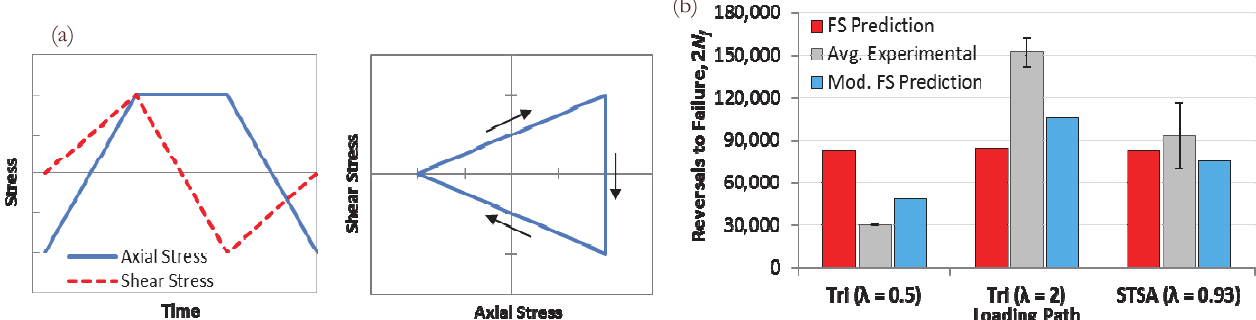
Figure 2: (a) Triangular load path in terms of stress-time history and shear vs. axial stress path, and (b) experimental and predicted fatigue life for discriminating load path